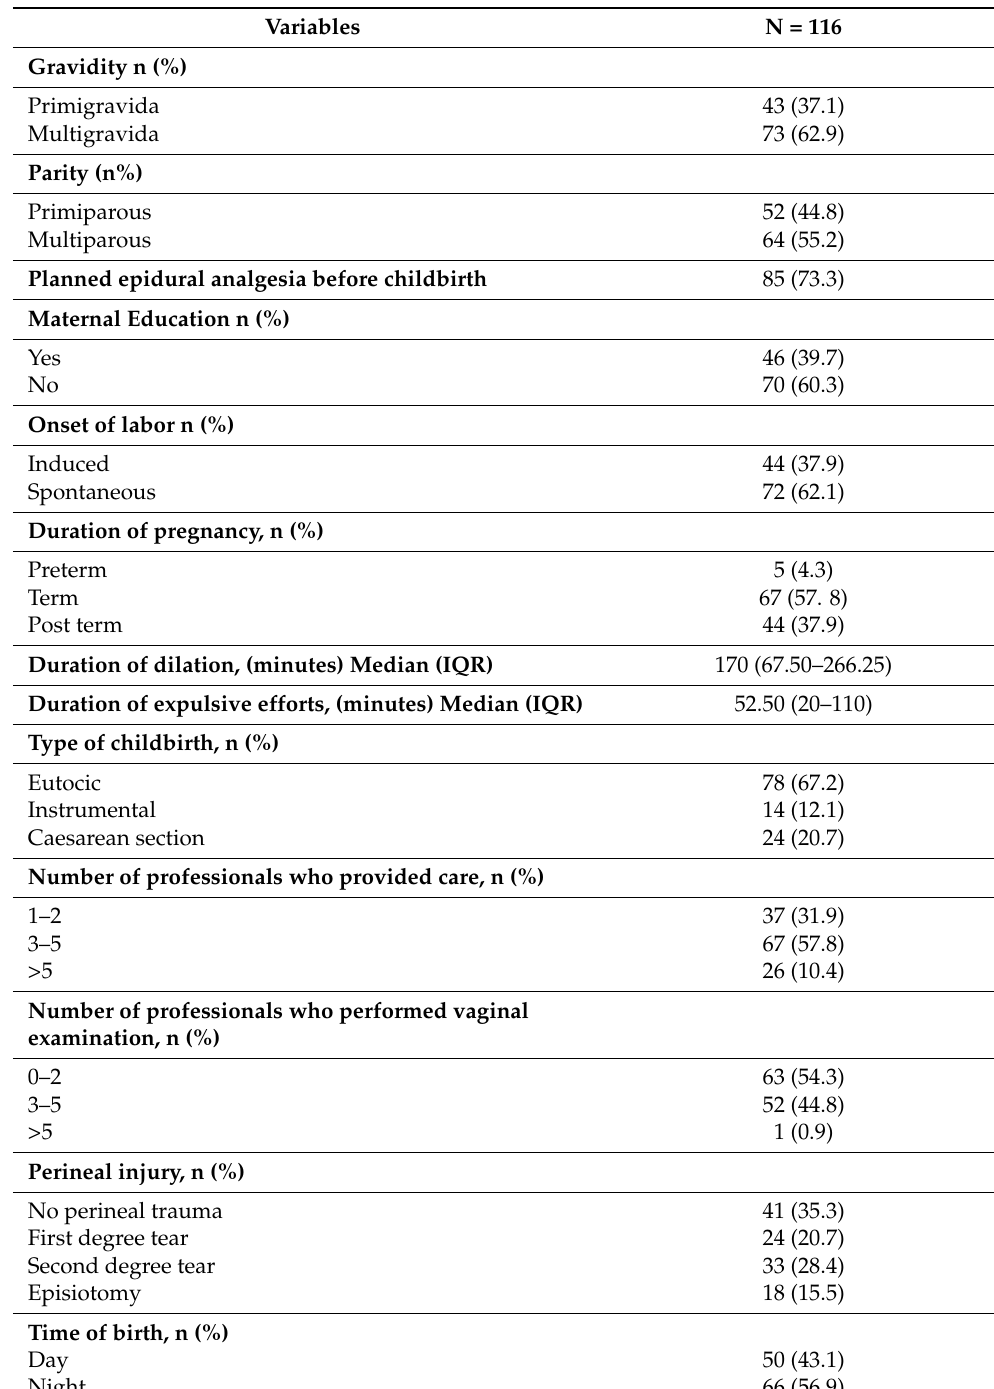
Table 2. Variables related to the